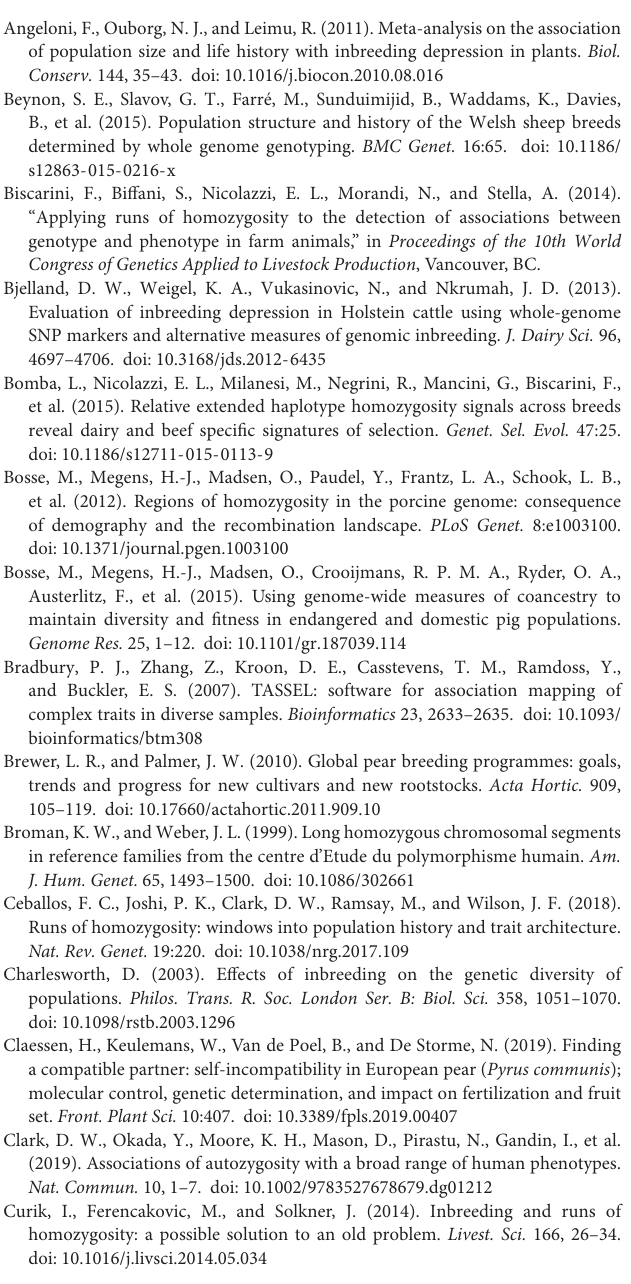
Supplementary Table S1 | The list of genomic regions of extended homozygosity (runs of homozygosity (ROH) islands). The overlap between genomic locations of ROH islands and previously published quantitative trait loci (QTLs) are approximated based on a recent review published by De Franceschi and Dondini (2019). Supplementary Table S2 | Genomic positions of trait-associated single nucleotide polymorphisms (SNPs) which resided within the runs of homozygosity (ROH) islands on different linkage groups (LG). The probability of significance and the minor allele frequency (MAF) at each SNP loci is also shown.